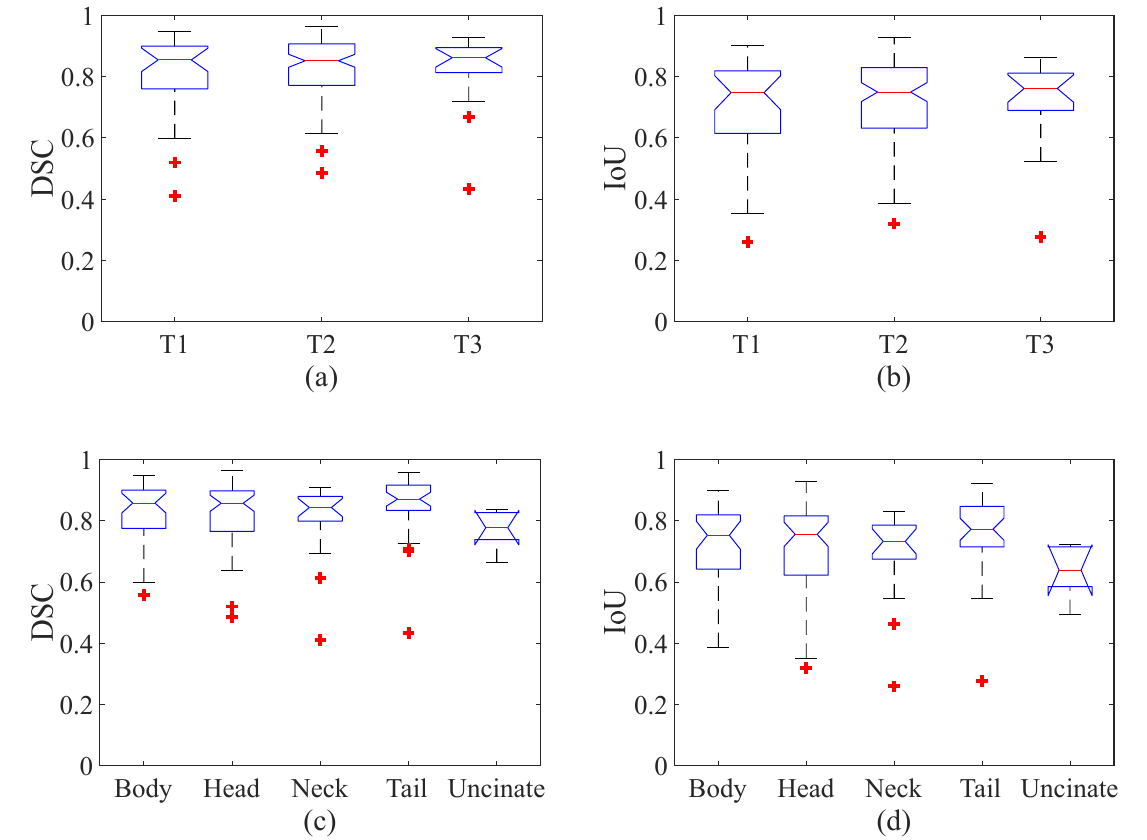
Figure 7. Statistical analysis for the ( a ) DSC and ( b ) IoU for three different cancer stages and the ( c ) DSC and ( d ) IoU for five different locations of the pancreatic cancer. (A red line inside the box represents the median value, the top and bottom whiskers represent the min and max of nonoutliers, respectively, and a red star indicates outliers.).